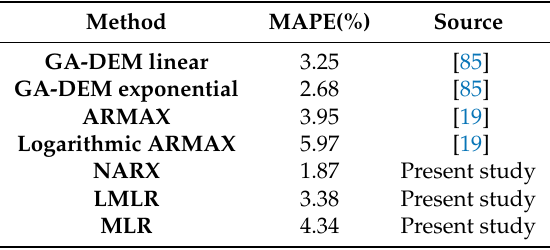
Table 6. Comparison of previous studies in RCEC prediction and present